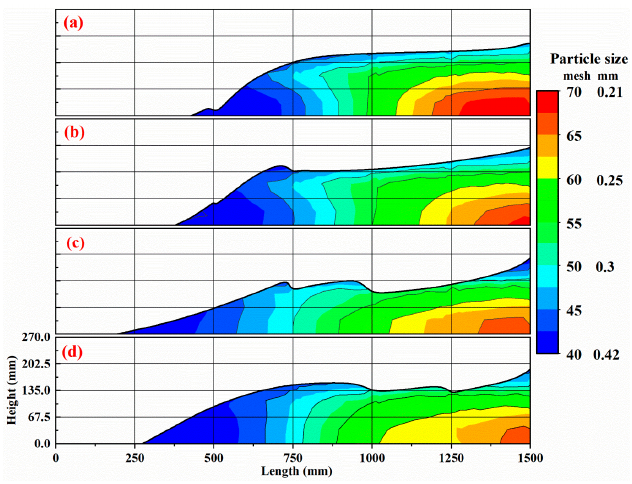
Figure 10. Mean particle size distribution across four channels: ( a ) L 1 /L = 0.16; ( b ) L 1 /L = 0.33; ( c ) L 1 /L = 0.5; ( d ) L 1 /L = 0.66.